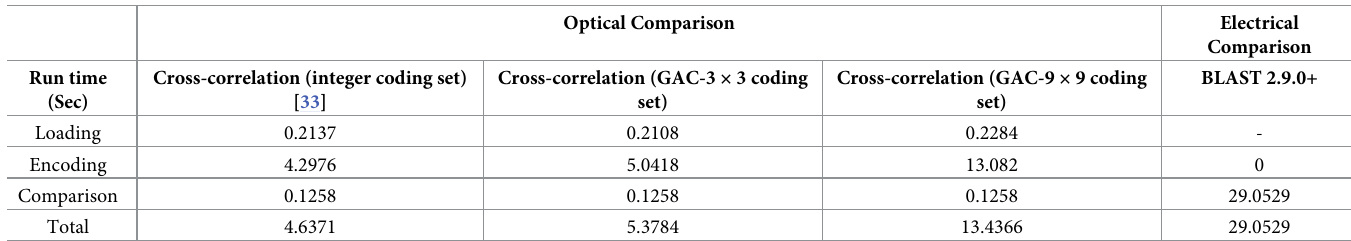
Table 9. Run time taken to process 303 query SEQUENCES IN 100 reference